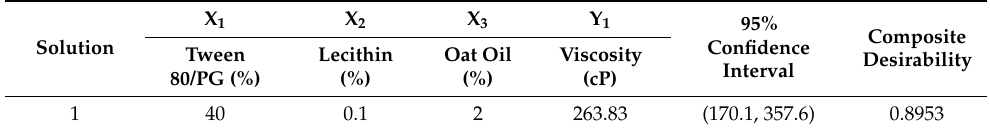
Table 9. Response optimization for viscosity by maximizing the response and keeping X 3 at maxi- mum level.